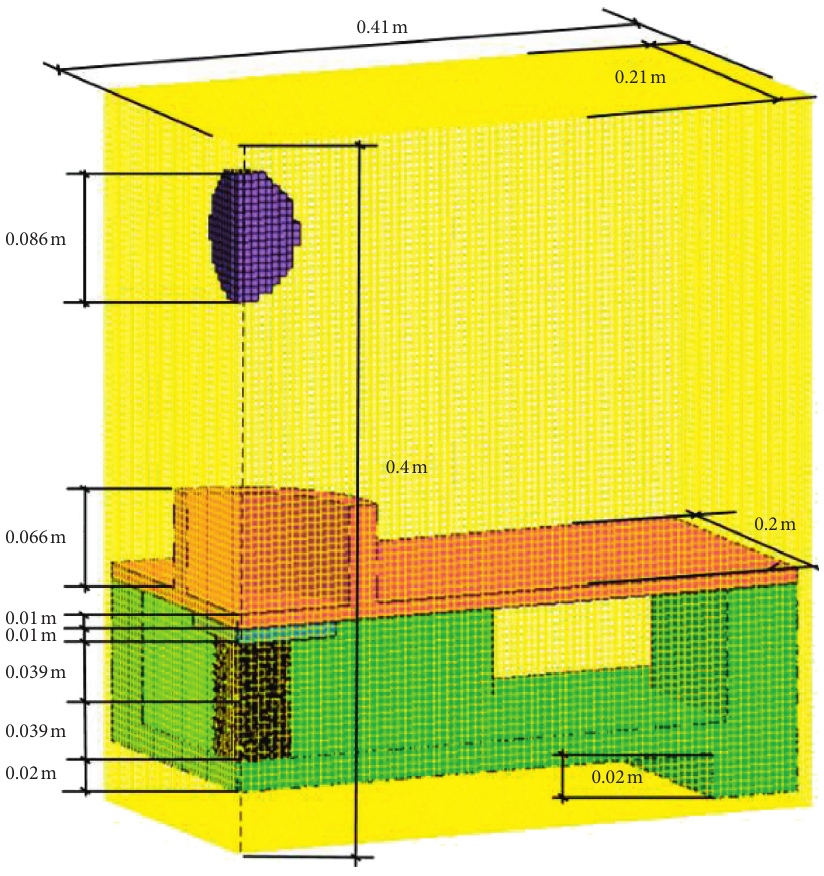
Figure 2: Double-layer aluminum foam sandwich (AFS)